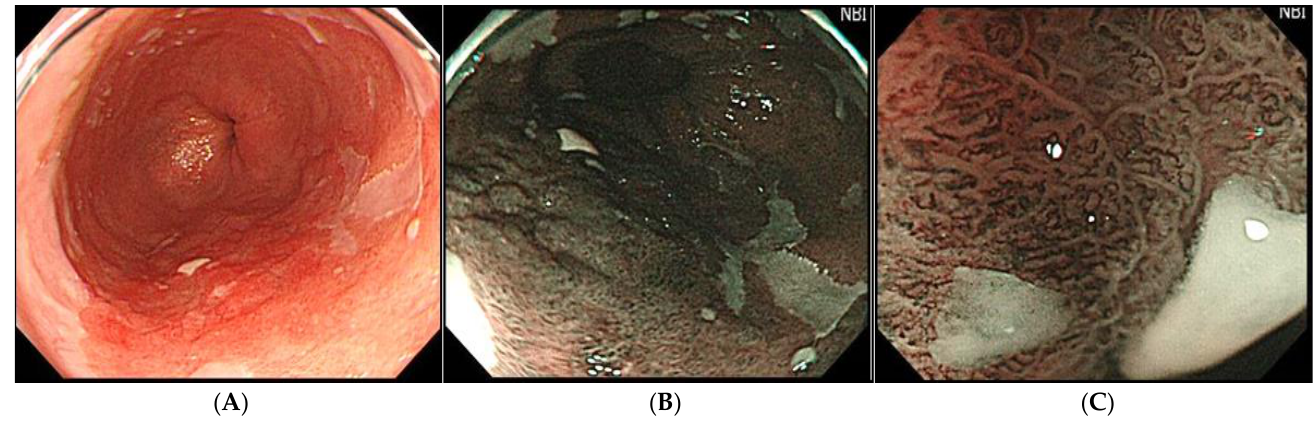
Figure 2. Representative images of superficial Barrett ’ s adenocarcinoma. ( A ): WLI: The lesion is a reddish nodular protruding lesion in the Barrett ’ s mucosa of LSBE (Prague classification C4M7), approximately semicircular from the 3 o ’ clock direction to the 8 o ’ clock direction. ( B ): NBI: NBI endoscopy showed a brownish-colored elevated lesion. The lesion is brownish compared to the surrounding NDBE, but the demarcation line is indistinct. ( C ): NBI magnifying endoscopy: NBI magnifying endoscopy reveals the irregular capillary vessels, the unstructured mucosa, and the irregularly dilated ductal structure in Barrett ’ s adenocarcinoma.